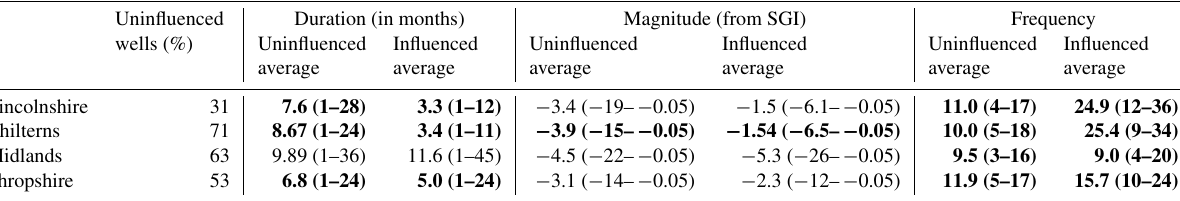
Table 2. Average drought characteristics (duration, magnitude, and frequency) of all monitoring sites in the four water management units. The 5th–95th percentile of the drought characteristics are in parentheses. Distribution plots for all drought characteristics can be found in Figs. S5–S7. The monitoring sites are separated using the lower limit of the cluster SPI Q –SGI into, on average, uninfluenced and influenced . Differences between the two groups are tested for significance using a Wilcox test. Tests for which the p < 0 . 05 are indicated in bold.